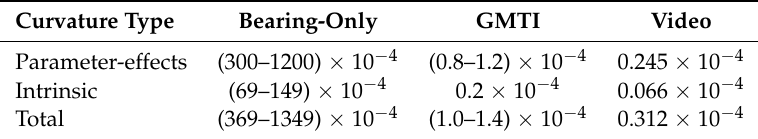
Table 2. MoNs for the bearing-only, GMTI, and video filtering